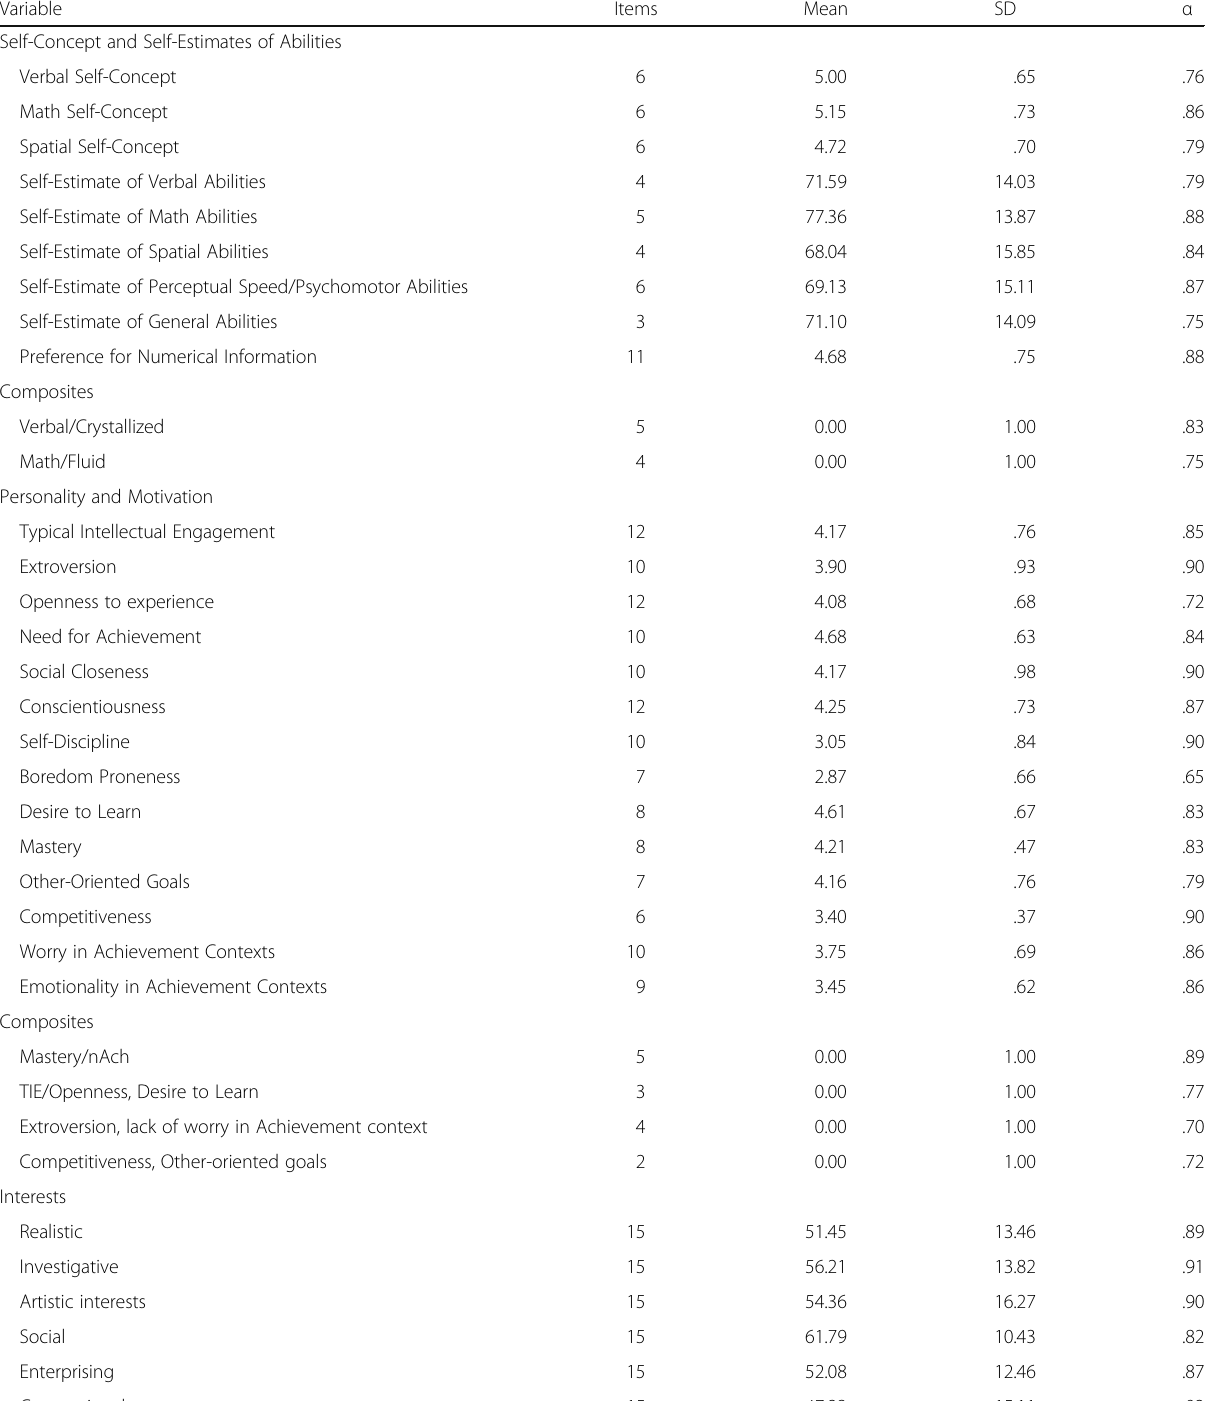
Table 3 Trait measures: number of items, means, reliabilities, and internal consistency reliability Variable Items